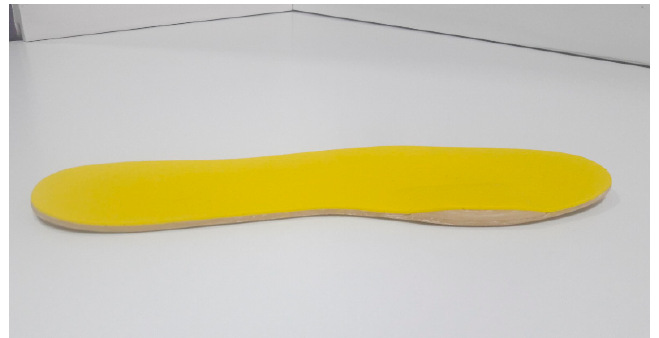
Figure 1. Novel inverted rocker orthotic (NIRO).